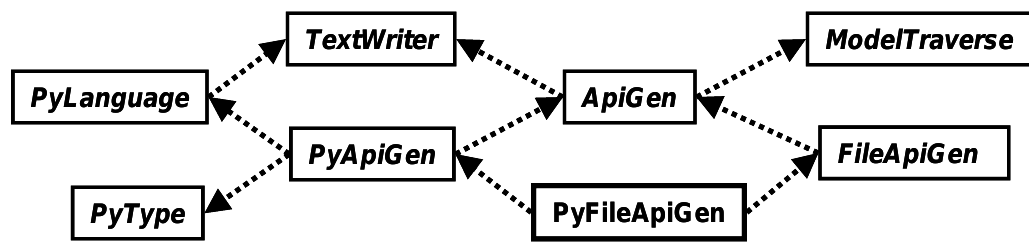
Supplementary Figure 3: API generator modules, specifically for the Python+XML API implementation. Each box represents a class. Inheritance is shown by dotted arrows from subtype to supertype – note that Python has no problems with multiple inheritance. The diagram for a Java+database implementation would have the same structure, with PyLanguage replaced by JavaLanguage, PyFileApiGen by JavaDbApiGen, etc. All classes are abstract, except for PyFileApiGen. The four 'ApiGen' classes contain the API generation logic – with ApiGen accounting for about half the code and FileApiGen for a third. ModelTraverse contains general looping and traversing code, while TextWriter contains code for writing to file. PyLanguage and PyType hold low-level language-specific code.